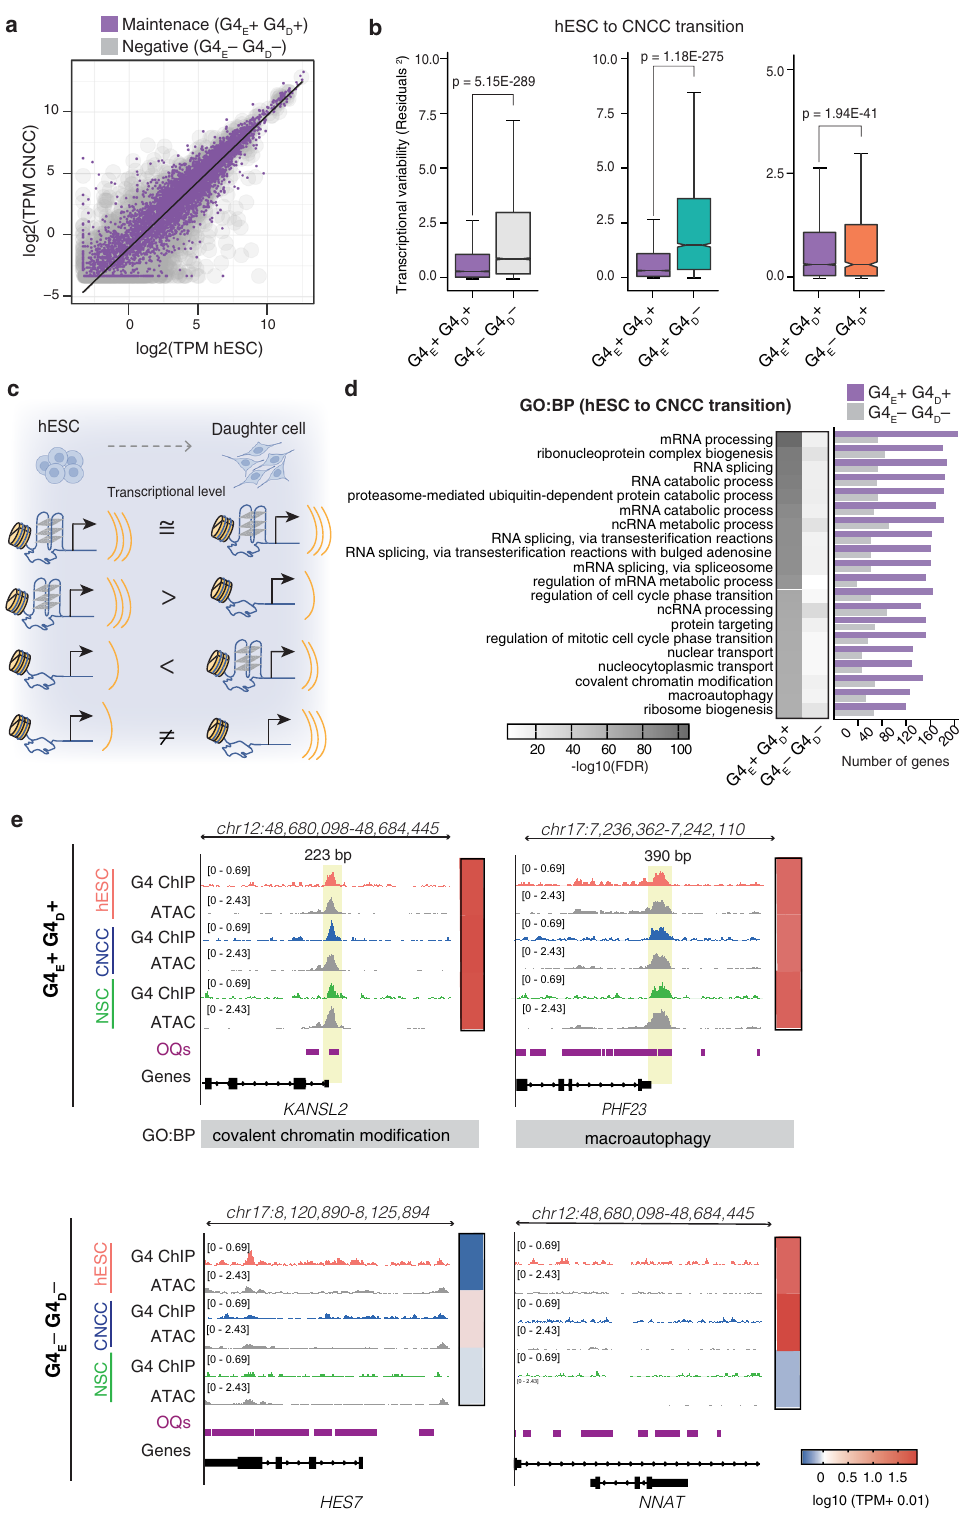
mRNA processing ribonucleoprotein complex biogenesis RNA splicing RNA catabolic process proteasome-mediated ubiquitin-dependent protein catabolic process mRNA catabolic process ncRNA metabolic process RNA splicing, via transesterification reactions RNA splicing, via transesterification reactions with bulged adenosine mRNA splicing, via spliceosome regulation of mRNA metabolic process regulation of cell cycle phase transition ncRNA processing protein targeting regulation of mitotic cell cycle phase transition nuclear transport nucleocytoplasmic transport covalent chromatin modification macroautophagy ribosome